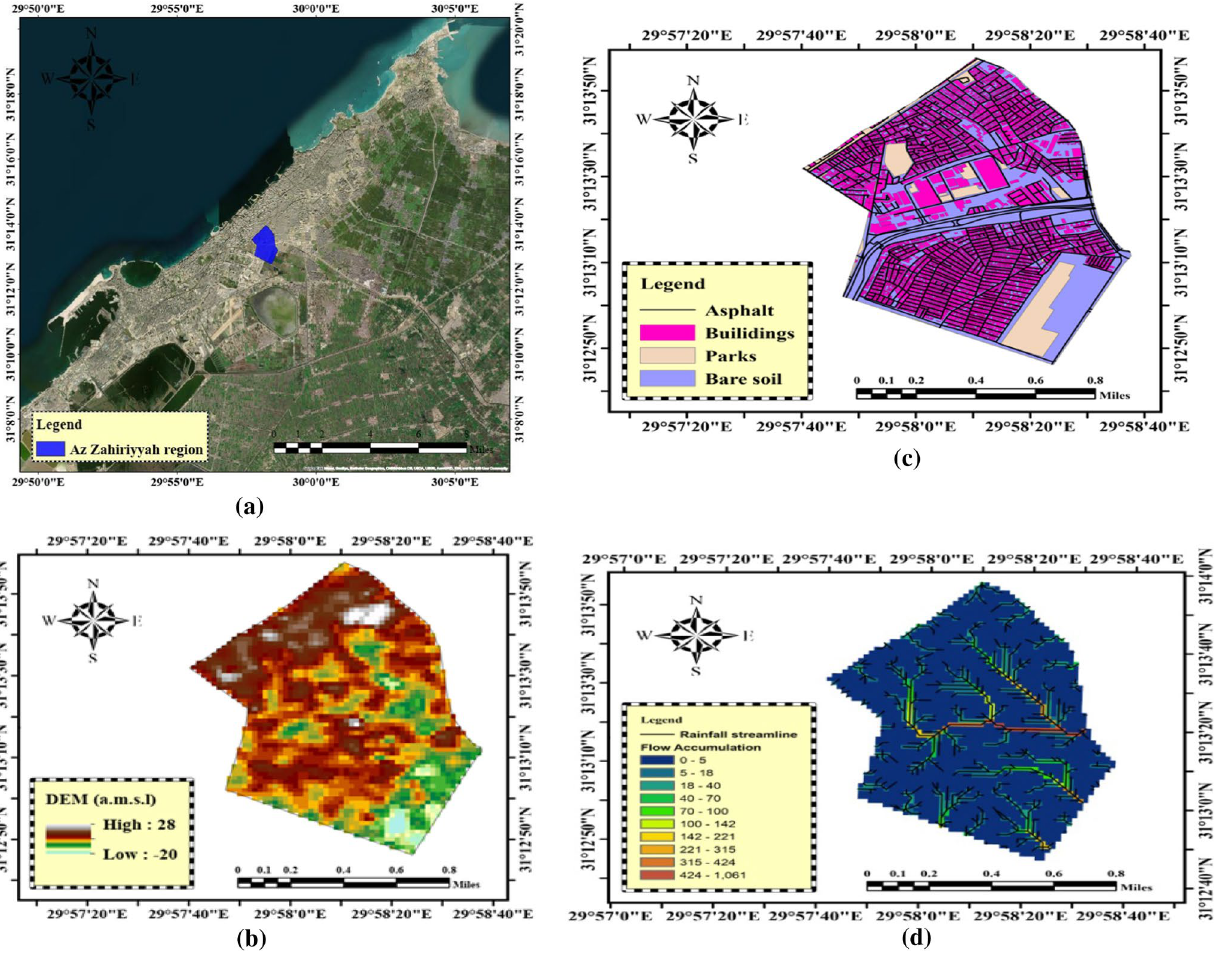
Fig. 7 a Google earth map, b digital elevation model, and c land-use map, and d flow accumulation map for Zaheria region in Alexandria city (Gabr et al.